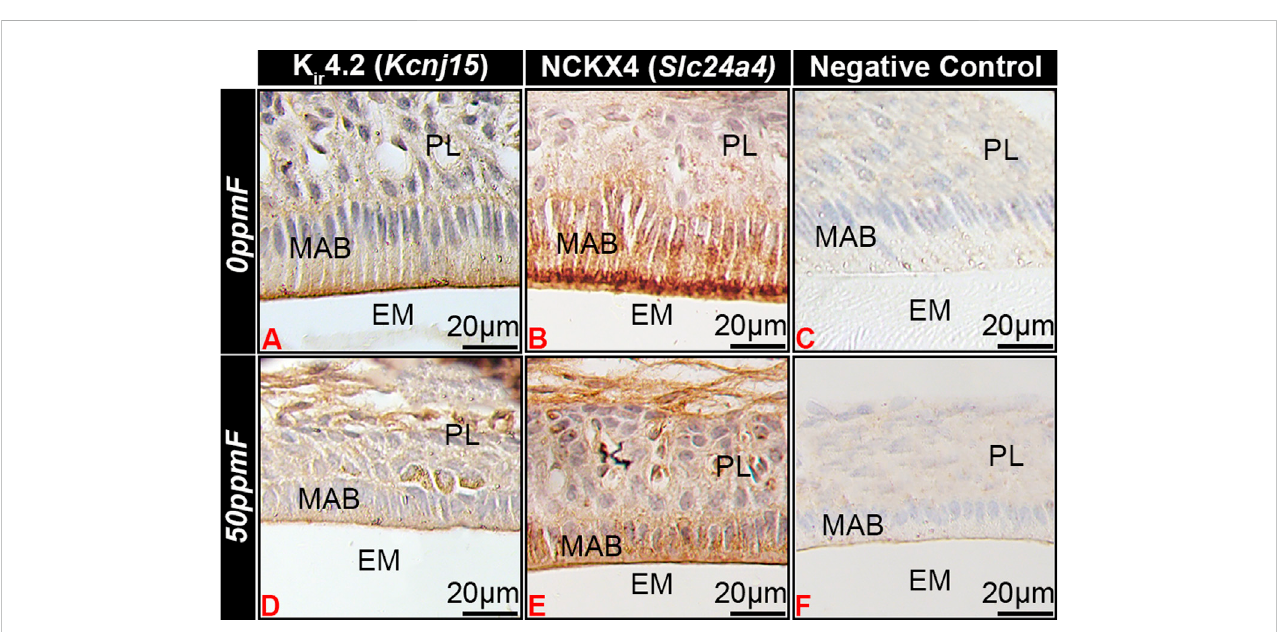
FIGURE 5 Fluorosis affects Kir4.2 ( Kcnj15 ) localization in maturation ameloblasts. In mice given 0 ppm fl uoride drinking water Kir4.2 ( Kcnj15 (A) and NCKX4 (B) localized to the apical border of ruf fl e-ended maturation stage ameloblasts. Fluorosed ameloblasts had reduced Kir4.2 ( Kcnj15 ) (D) and NCKX4 (E) at the apical border as compared to 0 ppm fl uoride controls. MAB, maturation ameloblast; EM, enamel matrix; PL, papillary